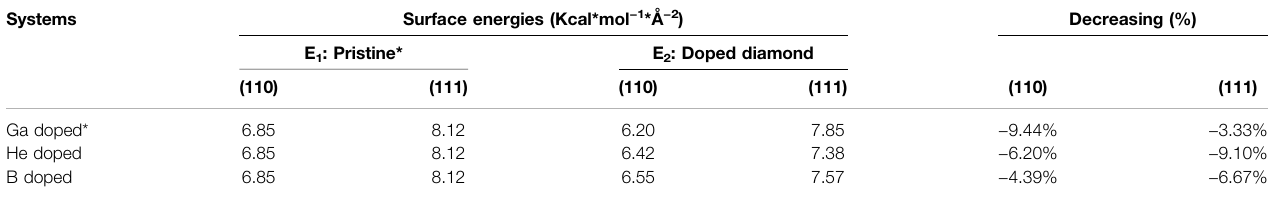
TABLE2| Surfaceenergiesforpristineanddopeddiamondsystemswith64 ° Catoms[Decreasing(%)iscalculatedbytheformula: E1 − E2 the previous theoretical work [Lee et al. (2019)]}. Systems